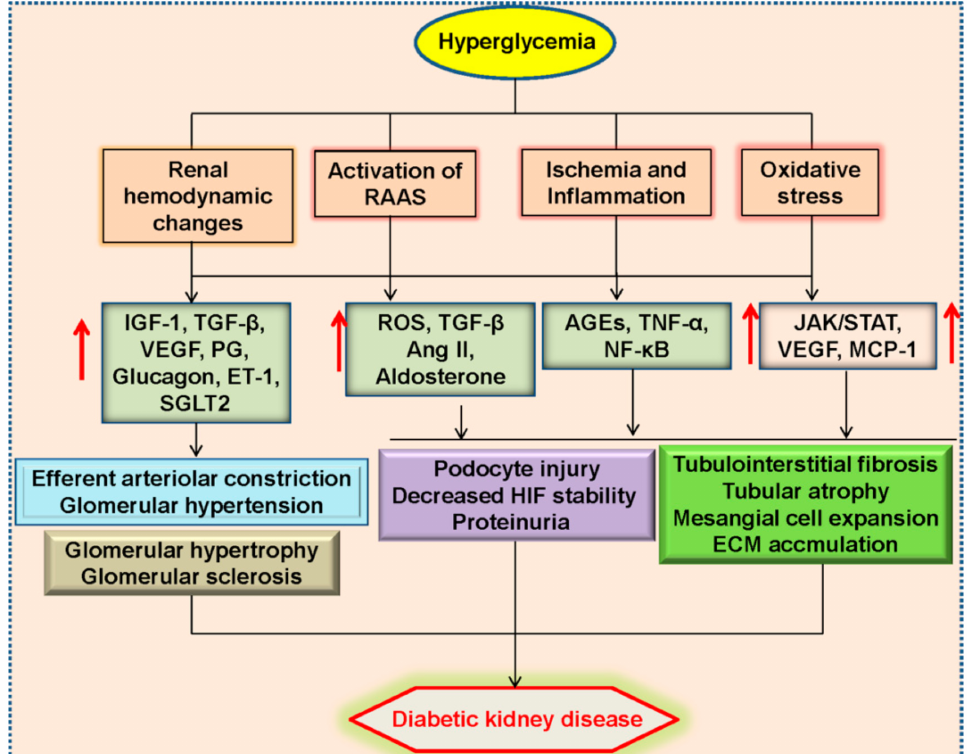
Figure 1. Conventional pathophysiology of diabetes kidney disease. Diabetic kidney disease is closely associated with renal hemodynamic changes, ischemia and glucose metabolism abnormalities, oxidative stress, inflammatory response and over-activated RAAS, which contributes to glomerular hypertension and sclerosis, tubulointerstitial fibrosis, tubular atrophy and mesangial cell expansion. RAAS, renin-angiotensin-aldosterone system; IGF-1, insulin-like growth factor 1; TGF- β 1, transforming growth factor β 1; VEGF, vascular endothelial growth factor; PG, prostaglandin; Ang II, angiotensin II; ET-1, endothelin-1; SGLT2, sodium glucose co-transporters 2; ROS, reactive oxygen species; AGEs, advanced glycation end products; TNF- α , tumor necrosis factor α ; NF- κ B, nuclear factor kappa-light-chain-enhancer of activated B cells; HIF, hypoxia-inducible factor; ECM, extracellular matrix; JAK / STAT, Janus kinase-signal transducer and activator transcription factor; MCP-1, monocyte chemotactic protein